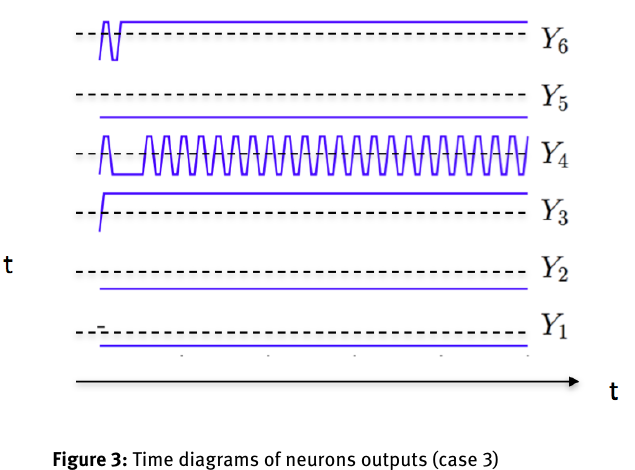
Figure 3: Time diagrams of neurons outputs (case 3)